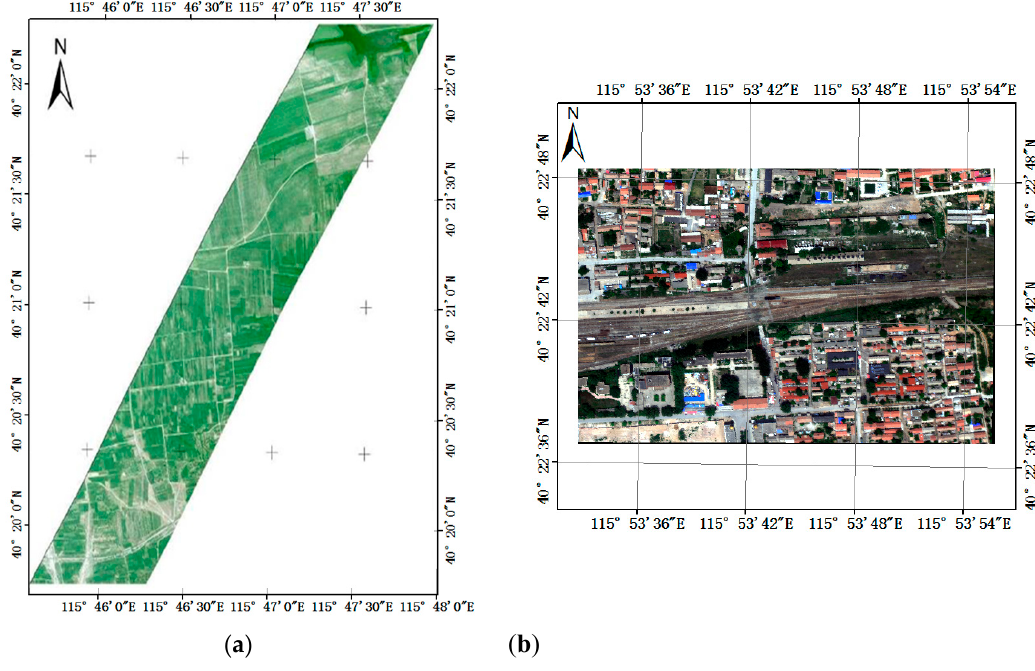
Figure 1. Map of the study area in Huailai County, Zhangjiakou City, Hebei Province, China: ( a ) the farmland; and ( b ) the village. Table 1. Basic specifications of CASI and SASI.